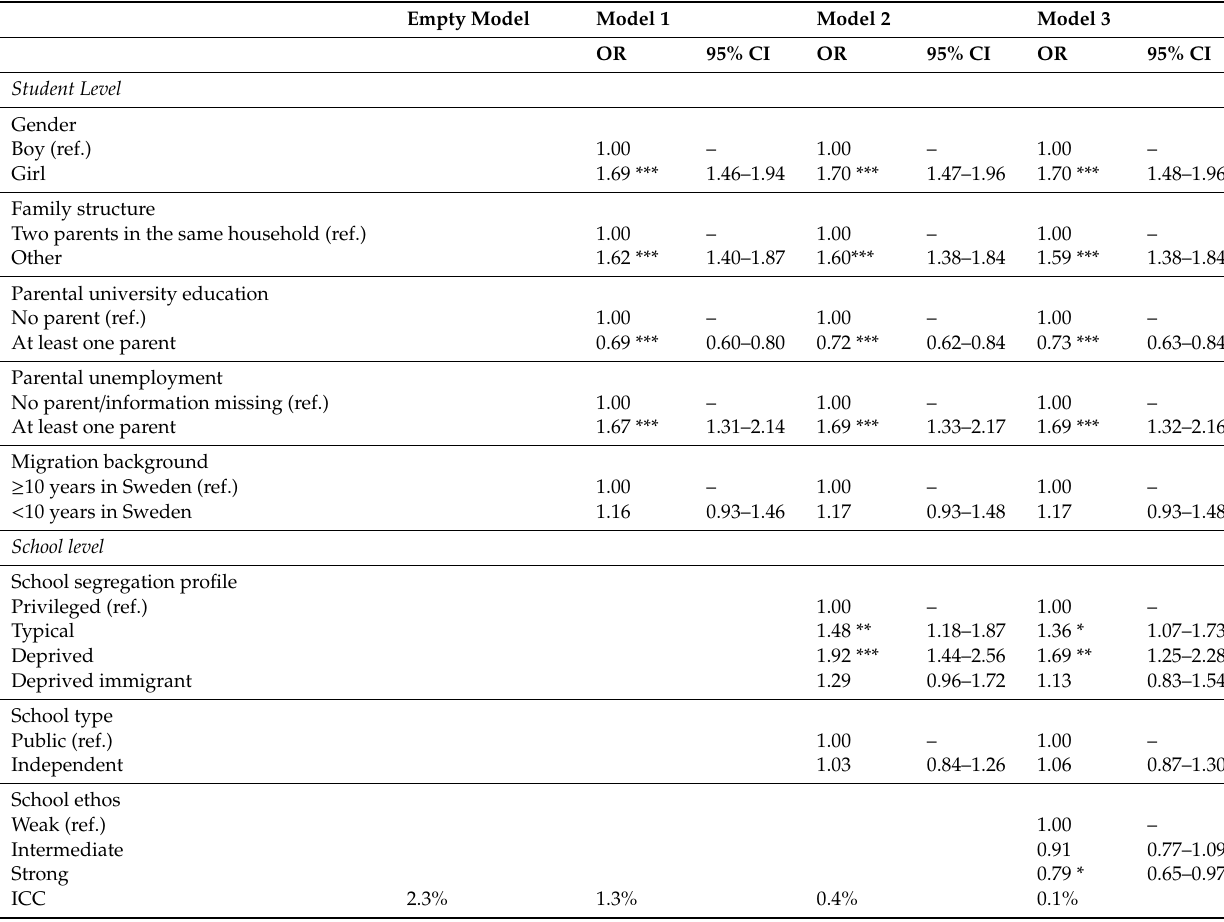
Table 3. Recurring sickness absence ( > 10 times vs. less) among students regressed on teacher-rated school ethos. Odds ratios from two-level binary logistic regression models. n = 9482 students distributed across 150 school